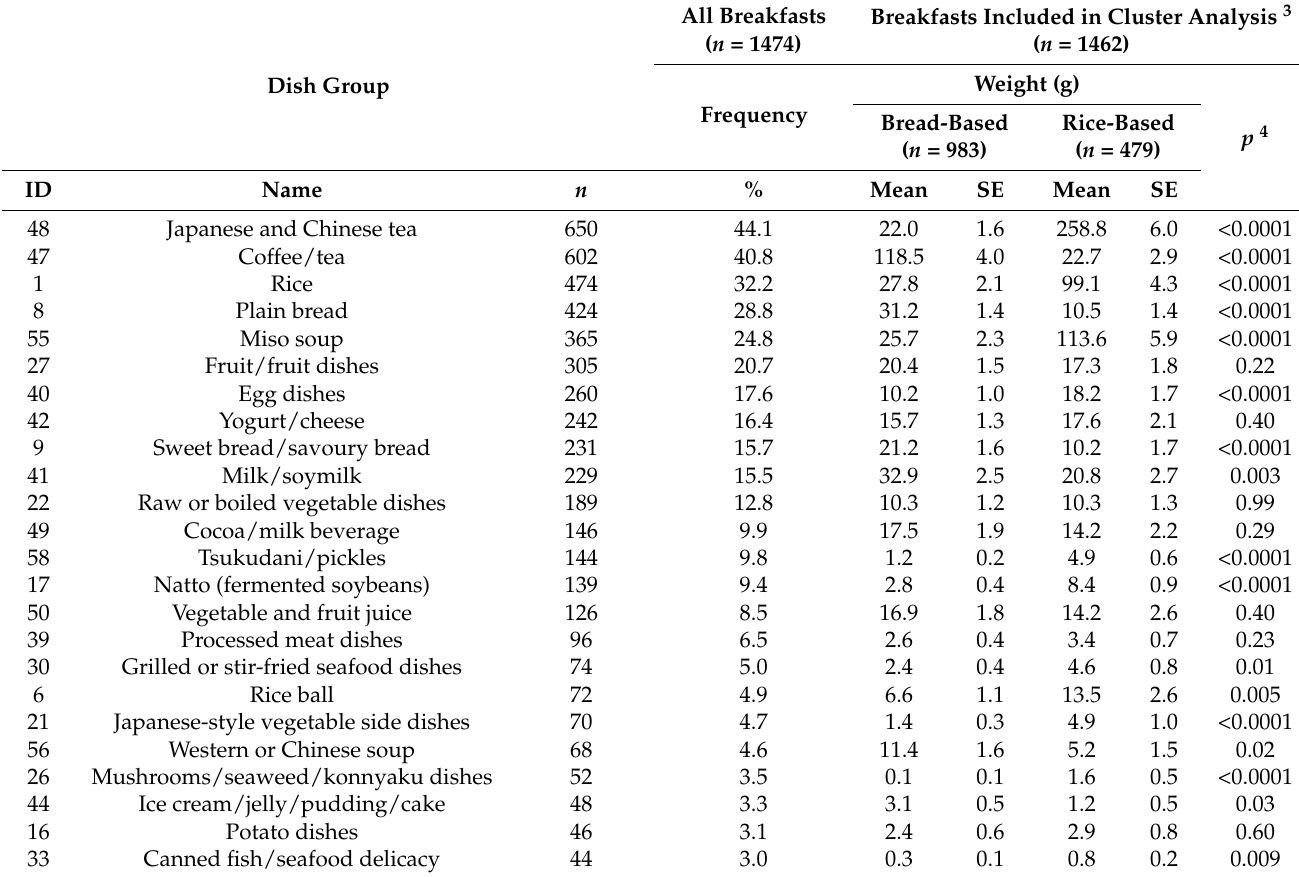
Table 1. Consumption frequency of dish groups in all breakfasts 1 and weight (g) of dish groups in each dietary pattern 2